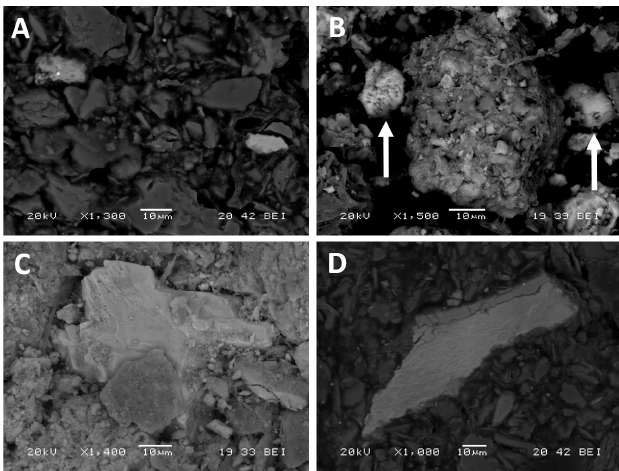
Figure 4. SEM images of selected grains (backscattered electron mode). ( A ) Soil mineral particles from Rita mine site: Those with higher atomic weight show higher brightness (scorodite with a residue of arsenopyrite on the left and a Fe-oxide on the right). ( B ) Two small particles of Fe-oxides from Las Viescas mine (marked with arrows), whose As contents are 2.74% and 8.76%, respectively. ( C ) Fe-oxide subhedral grain from Tres Amigos mine with a content of 2.80% As. ( D ) Mn-oxide grain from Rita mine in which no As was detected.